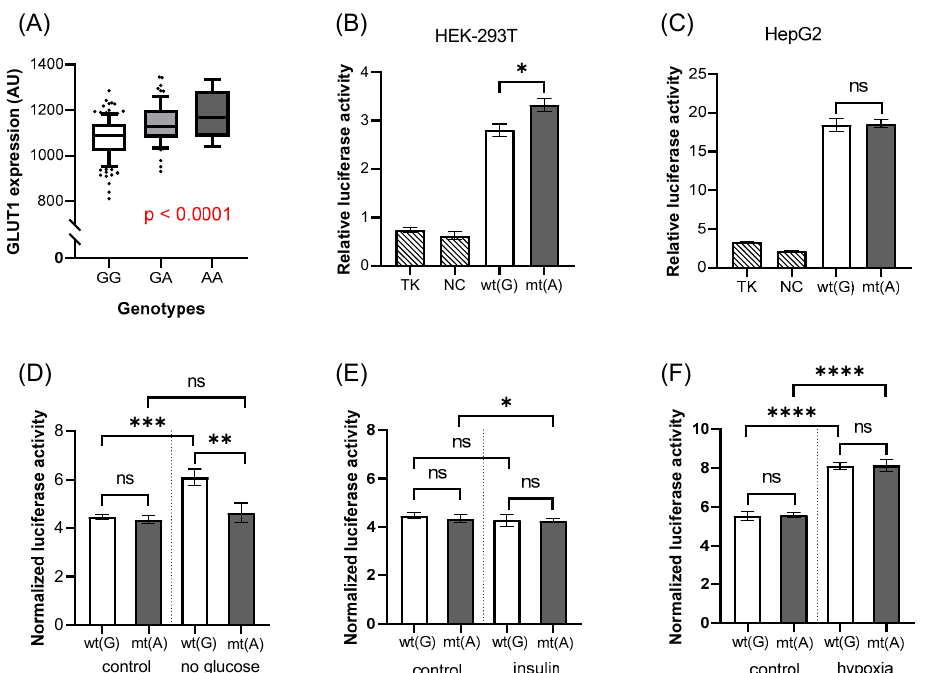
Figure 2. The effects of rs1385129 on GLUT1 expression and luciferase activity. The association between the expression of GLUT1 membrane protein and the genotypes of the variant ( A ). Each boxplot represents samples with different genotypes, in the range of 10–90 percentile, while dots represent samples out of range. Values are expressed as means ± SD. This insert has increased luciferase activity in HEK ‐ 293T ( B ) and HepG2 ( C – F ) cells compared to the empty vector, and the mutant allele increases this effect in HEK ‐ 293T cells ( B ). Wild ‐ type allele has a stimulating effect on luciferase expression under low concentrations of glucose. Insulin has no effect on this region, while hypoxia increases luciferase expression, regardless of the alleles. The p ‐ values of the luciferase experiments ( B – F ) were calculated using the Welch t ‐ test. The stars represent significance at different levels: * p < 0.05, ** p < 0.01, *** p < 0.001, **** p < 0.0001. In the case of the treatments, data were normalized to the results of the “empty” vector. wt(G): wild ‐ type allele; mt(A): mutant allele; TK: “empty” vector without insert; NC: negative control (random sequence); ns: not significant; AU: arbitrary unit.